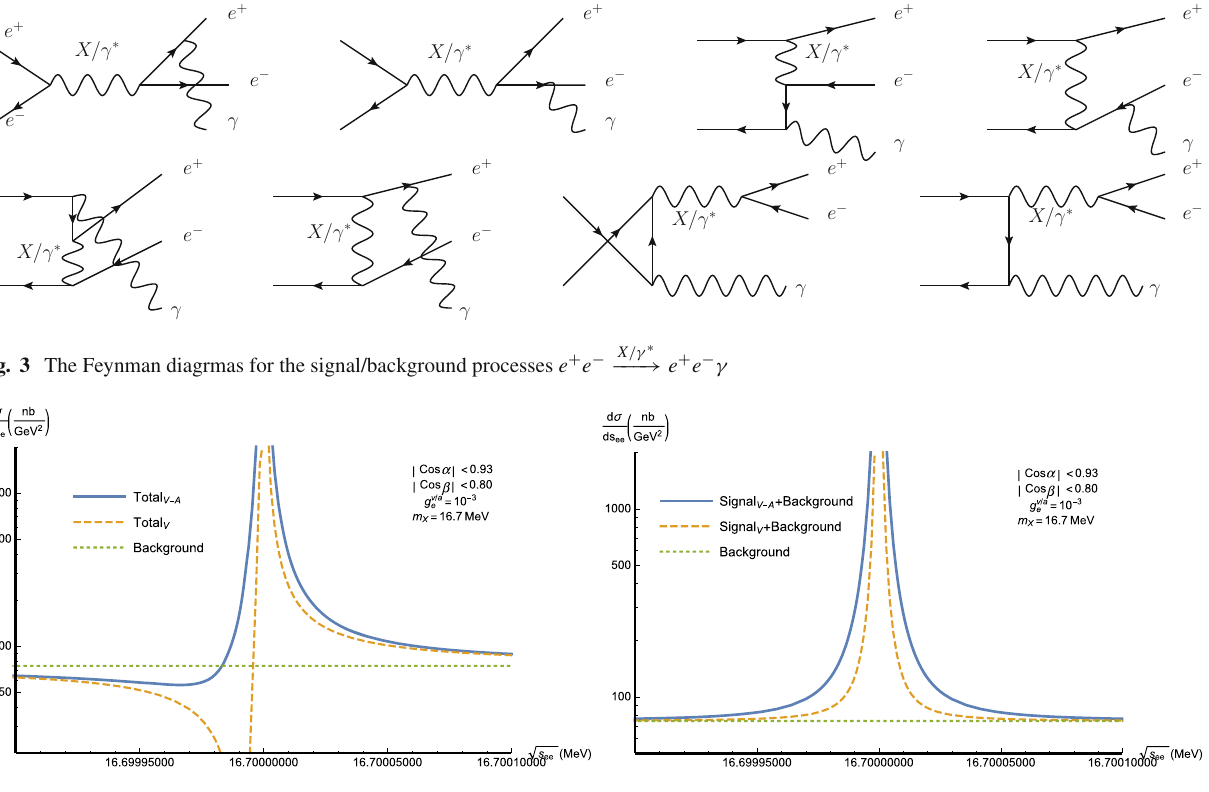
Fig. 4 The differential cross-section with respect to the invariant- cesses, where we have adopted the good tracks conditions for both electron/positron and photon. Left: “Total” means it contains the